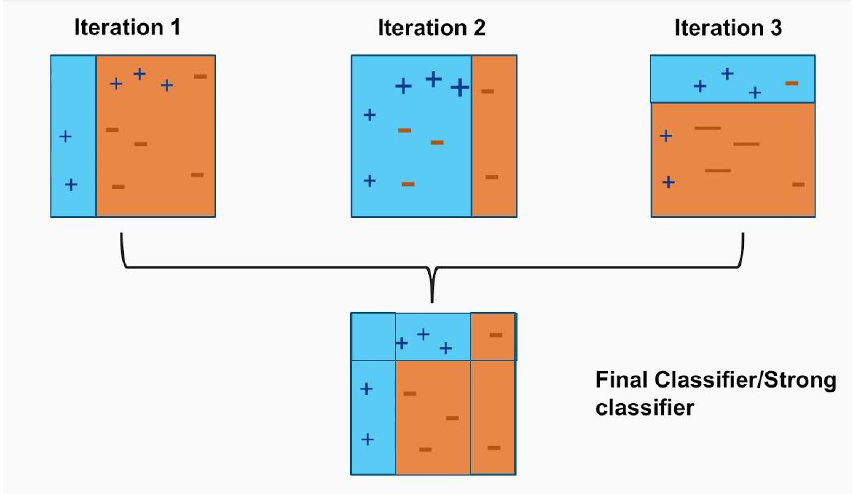
Figure 6. Adaptive boosting (AdaBoost) algorithm.